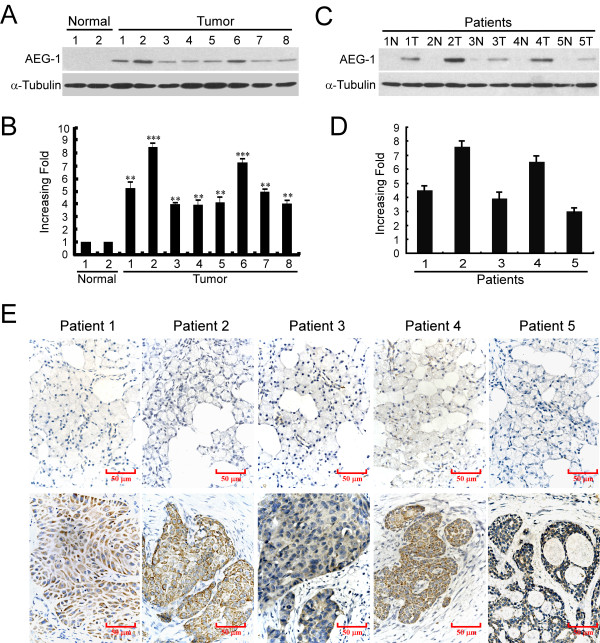
Upregulation of AEG-1 expression in SGC tissues. (A and B) Expression of AEG-1 protein and mRNA in 2 normal human salivary gland tissues and 8 SGC tissues by Western blot (A) and real-time PCR (B), respectively. *P < 0.05, ** P < 0.01, *** P < 0.001. (C) Expression of AEG-1 protein in each of the primary SGC tissues (T) and adjacent non-cancerous tissues (N) in the same patient determined by Western blot. (D) Real time-PCR analysis of AEG-1 expression in each of the T and N tissues. GAPDH was used as an internal control. Columns, mean from three parallel experiments; bars, SD. (E) Expression of AEG-1 mRNA in each of the primary SGC tissues (lower panel) and adjacent non-cancerous tissues (upper panel) paired from the same patient determined by IHC.